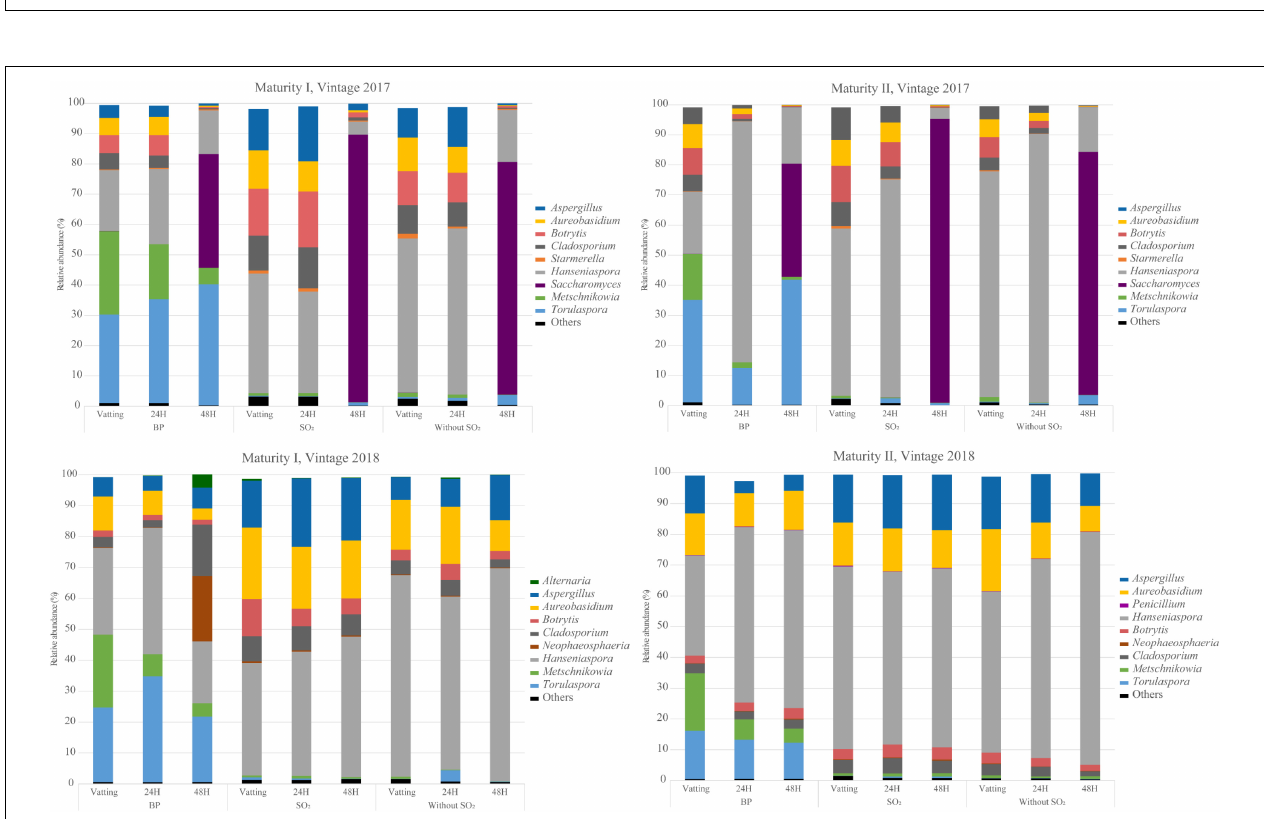
FIGURE 3 | Relative abundances (%) of 9 major genus of Ascomycota phylum for all sample during prefermentary stages (Vatting, 24H and 48H of maceration) in two vintages (2017 and 2018) and two maturities [technological (I) and advanced maturities (II)]. Bioprotection (BP), SO 2 and Without SO 2 treatments in early stages of winemaking. Results of each sample is the mean of biological replicats ( n = 3 technological maturity, n = 2 advanced maturity).